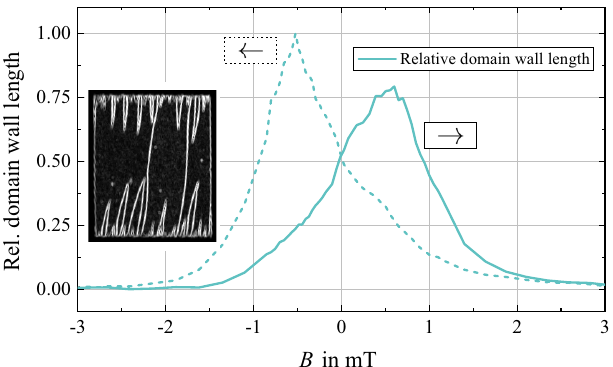
Figure 4. Relative magnetic domain wall evolution for increasing ( → ) and decreasing ( ← ) direction of external field B obtained via edge detection from the magnetooptical micrographs. The intensity from the domain wall contrast obtained by the edge detection operation is interpreted as a value related to the magnetic domain wall length. An example on an edge detection filtered intensity analyzed image is